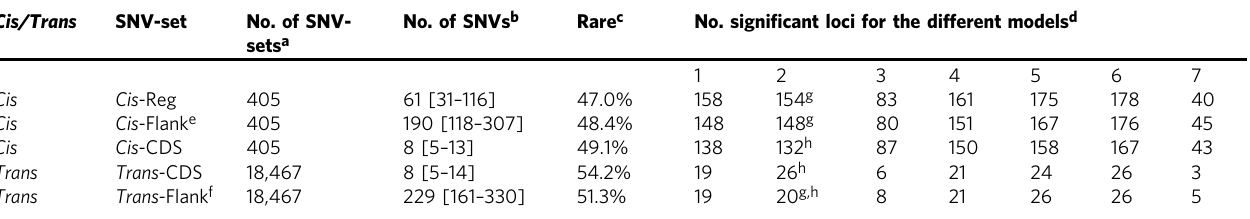
Table 1 Overview and summary statistics for the fi ve types of SNV-sets analysed and the number of signi fi cant loci identi fi ed with each of the seven SKAT models